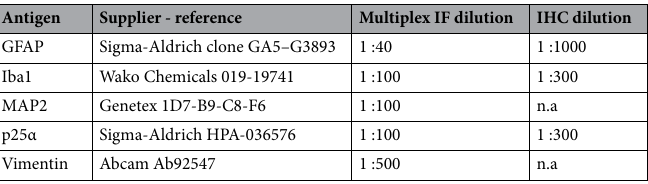
Table 2. List of